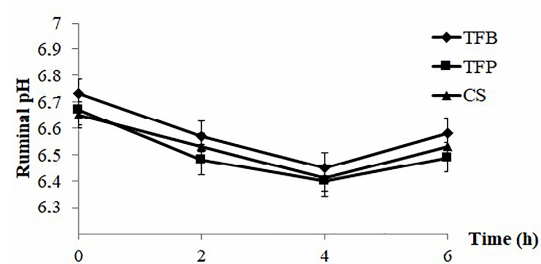
Figure 1. Evolution of ruminal pH post feeding of ewes according to the type of concentrate (TFB, TFP, and CS) included in the ewes’ ration (1.8kgd − 1 of oat hay + 500gd − 1 of